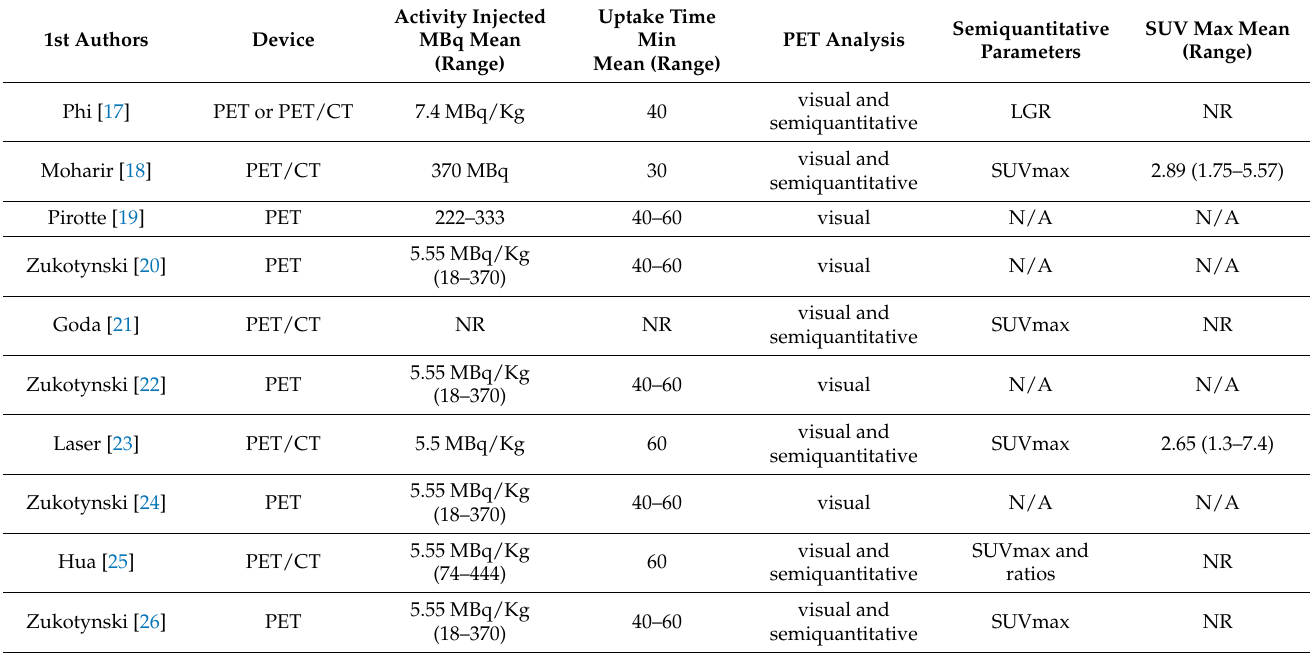
Table 2. Technical features of the main studies using 18F-FDG PET imaging in pediatric brain